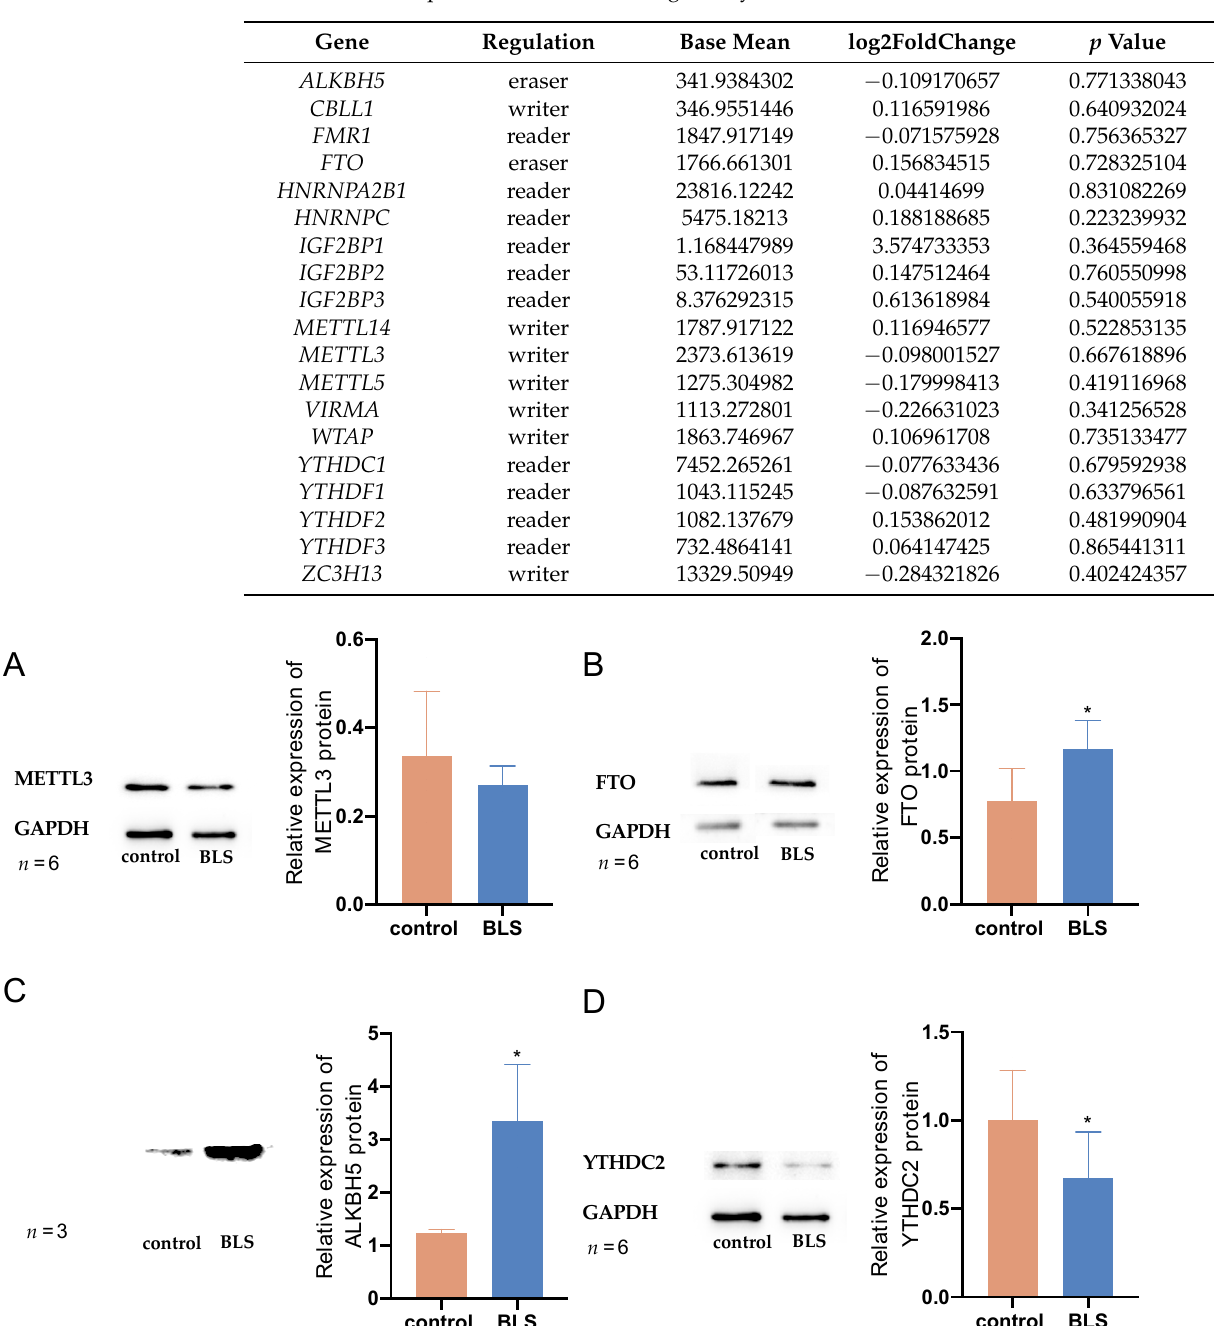
Table 2. mRNA expression level of m6A regulatory factor in LHb.